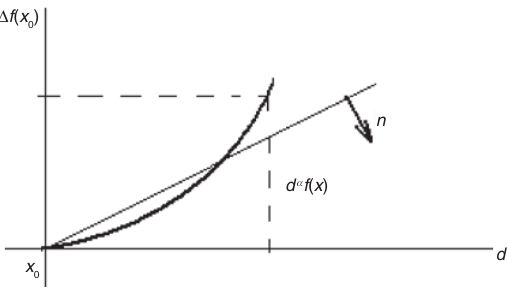
Figure 2: The virtual tangent space of the f ( x ) at the point x = x